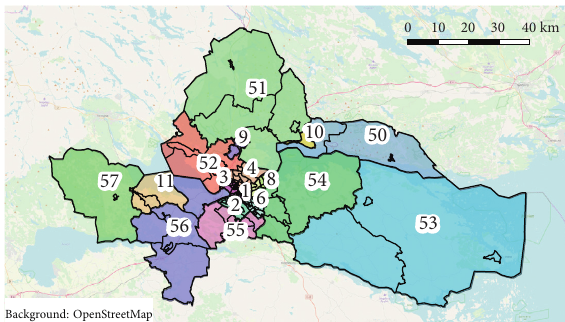
Figure 5: Map of Norrk¨oping municipality. The coloured 24 zones labelled with their ID are an aggregation of the 189 zones used by the municipality’s traffic model, which are shown with gray out- lines. External zones are not